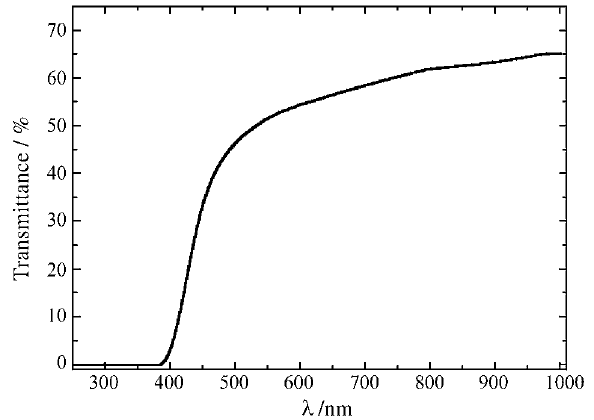
Figure 4. Transmittance spectrum of a 0.9 mm thick PLZT 10/65/35 ceramic.